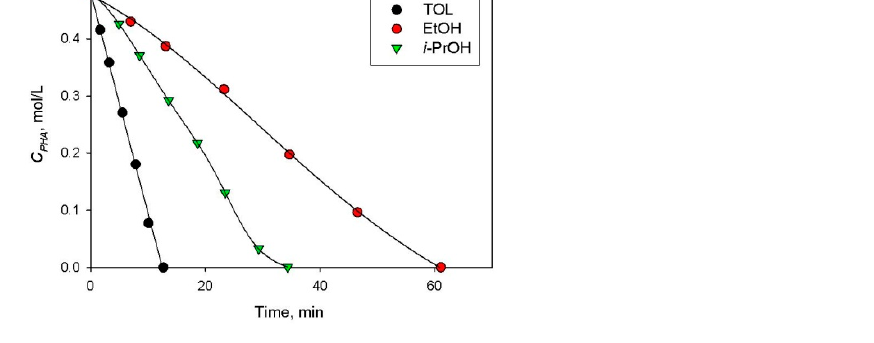
Figure 11. Solvent effect on PHA hydrogenation to STY over 1wt.% Pd/HPS-NR 2 (ambient H 2 pressure, C PHA ,0 = 0.48 mol/L, catalyst loading 30 mg).